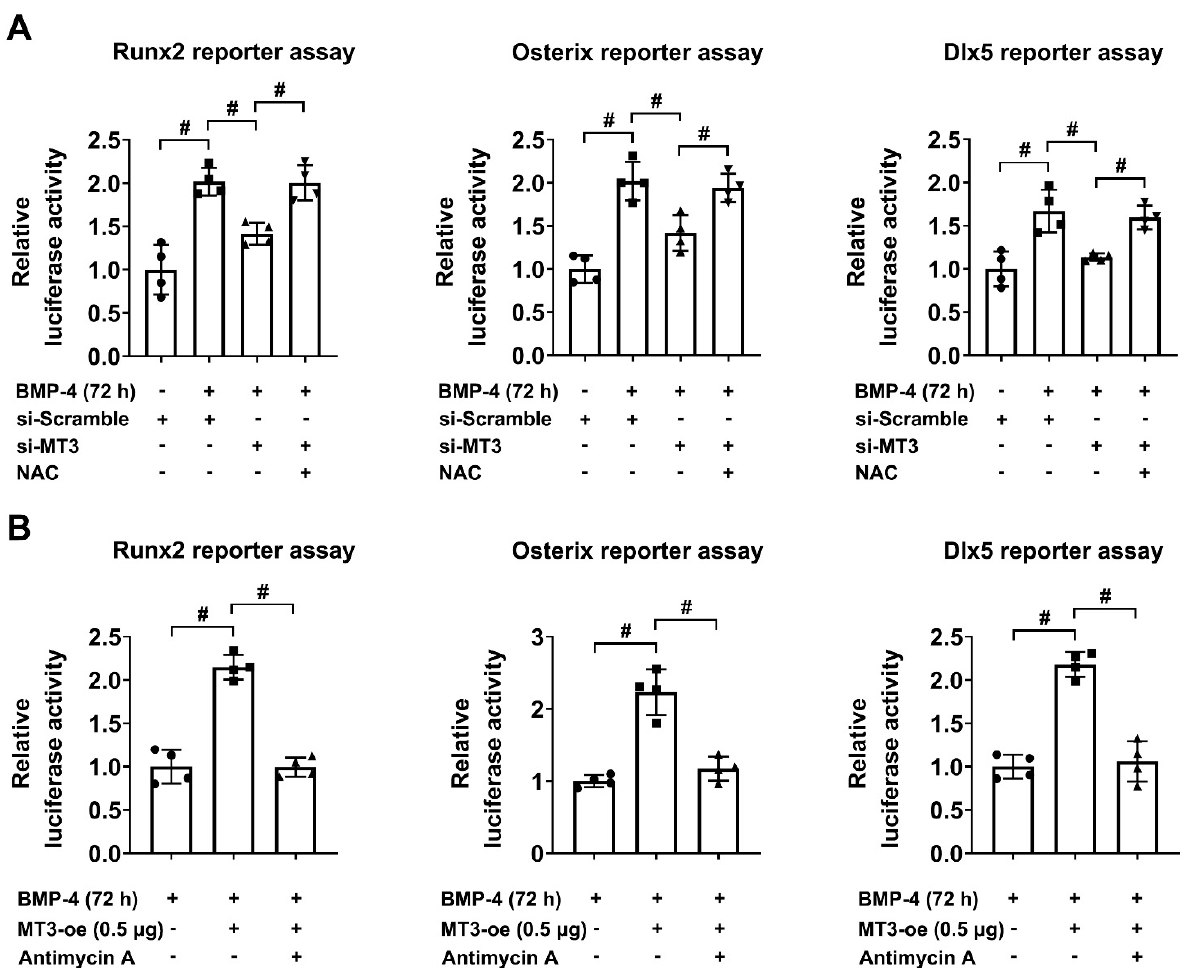
Figure 6. Oxidative stress affects the reporter activities of Runx2/Osterix/Dlx5 in MT3-overexpressing/silencing C2C12 cells. ( A ) Luciferase reporter activities of Runx2, Osterix, and Dlx5 in control or MT3-overexpressing C2C12 cells treated with or without recombinant BMP4 for 72 h in the absence or presence of NAC (10 mM). ( B ) Luciferase reporter activities of Runx2, Osterix, and Dlx5 in control or MT3 knockdown C2C12 cells treated with recombinant BMP4 for 72 h in the absence or presence of antimycin A (0.5 μ M). All data are presented as mean ± SEM, # p < 0.05.